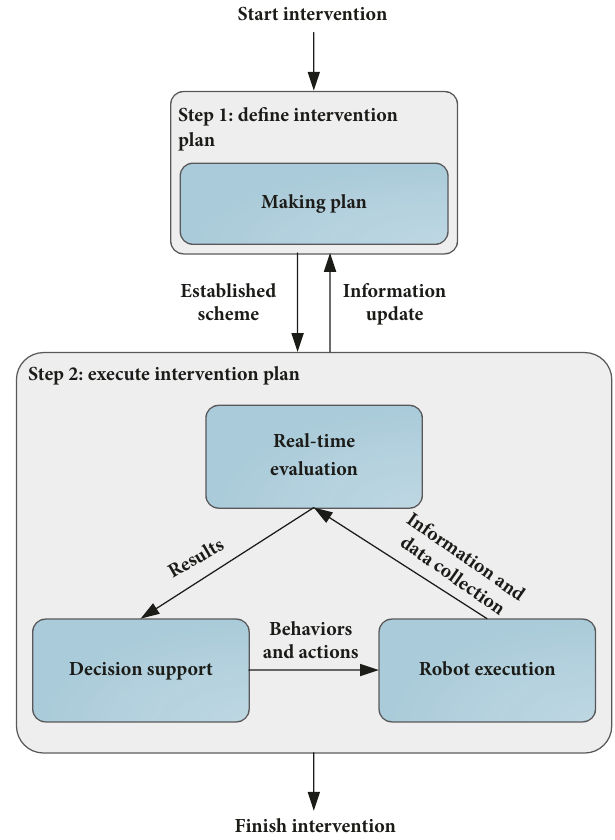
Figure 7: Steps of robot-assist behavioral